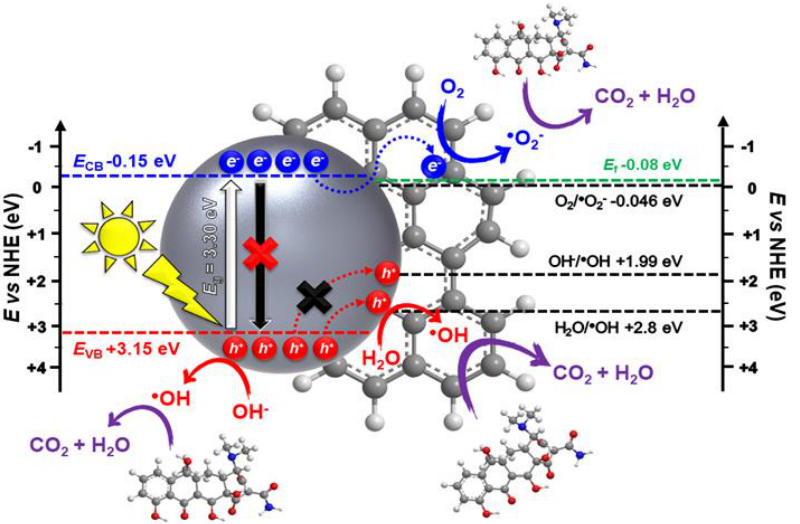
Figure 13. The possible mechanism of photocatalytic degradation of TC in the presence of rGO/CdWO 4 under solar irradiation. Reprinted with permission from [47].